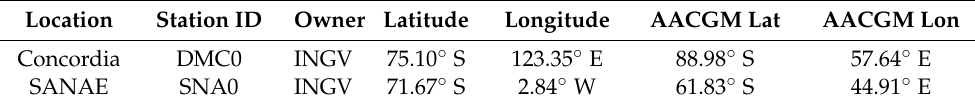
Table 1. Locations, identifiers, geographic and Altitude Adjusted Corrected GeoMagnetic coordinates (AACGM Lat and AACGM Lon) of the ISMRs used in this study. ISMR = Ionospheric Scintillation Monitoring Receiver. Location Station ID Owner Latitude Longitude AACGM